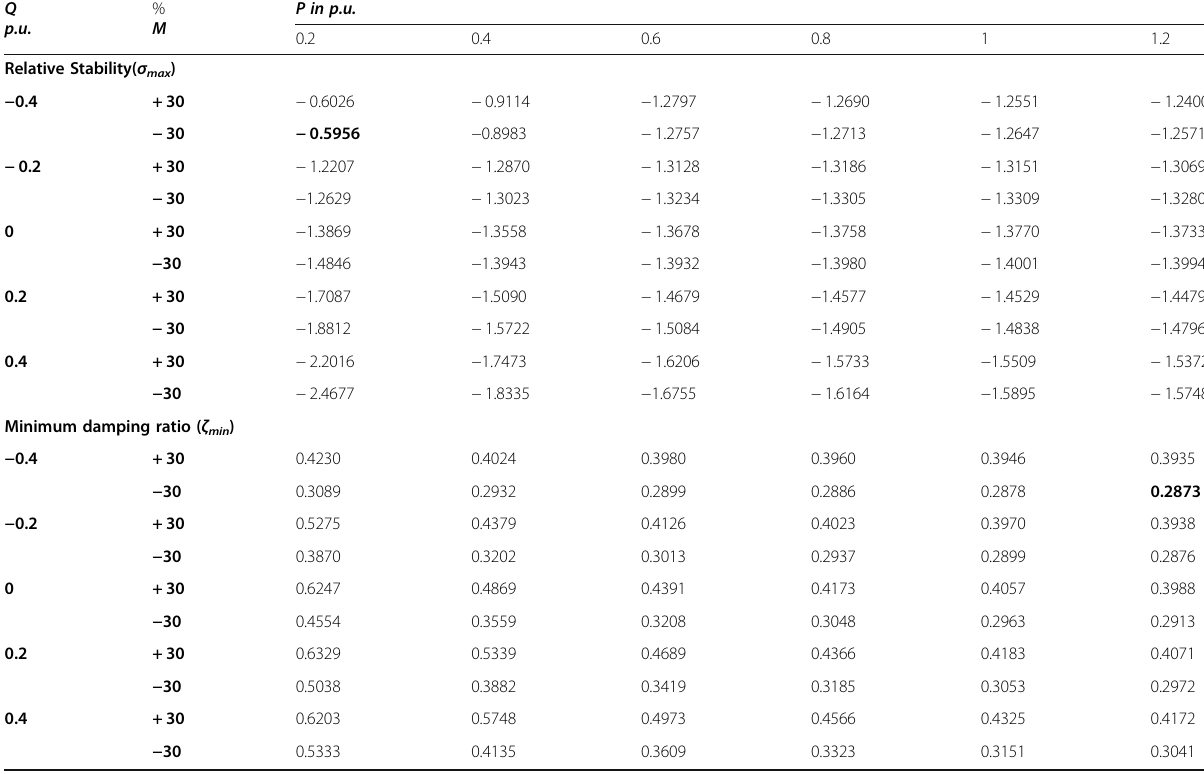
Table 4 Relative stability and minimum damping ratio for ±30% changes in machine inertia constant ( M ) Q % P in p.u. p.u. M